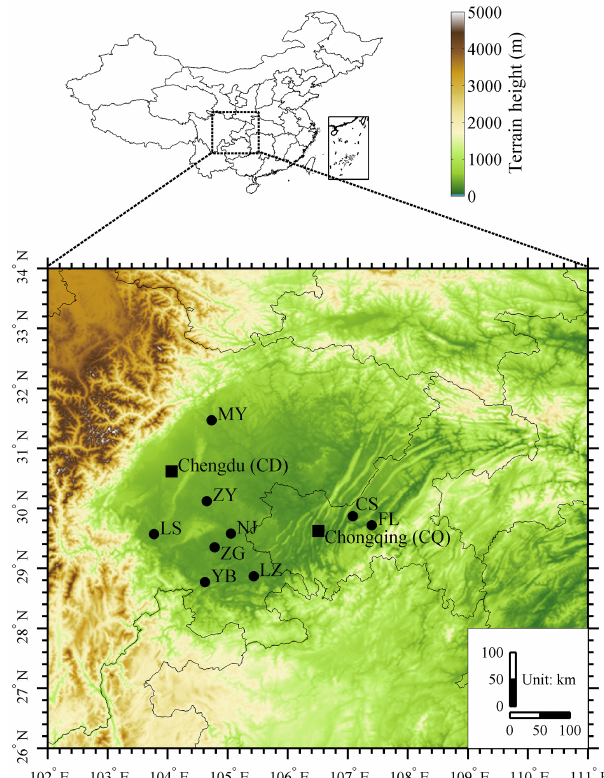
Figure 1. Locations of the sampling sites in Chengdu (CD) and Chongqing (CQ) and major cities in the Sichuan Basin. MY, Mi- anyang; ZY, Ziyang; LS, Leshan; NJ, Neijiang; ZG, Zigong; YB, Yibin; LZ, Luzhou; CS, Changshou; FL,